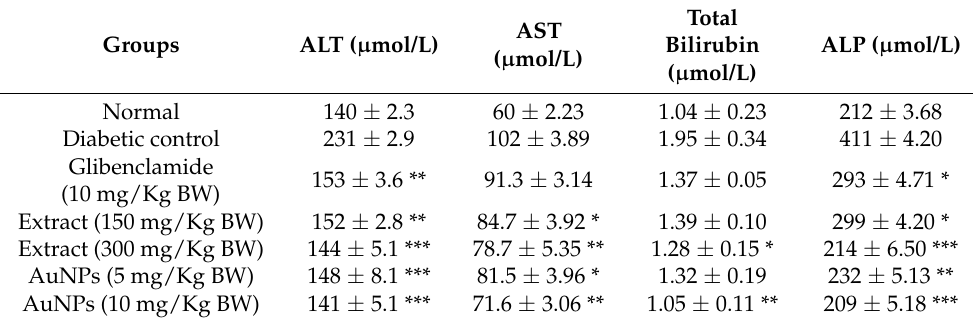
Table 10. Effect of methanol extract and AuNPs on rat’s liver function.